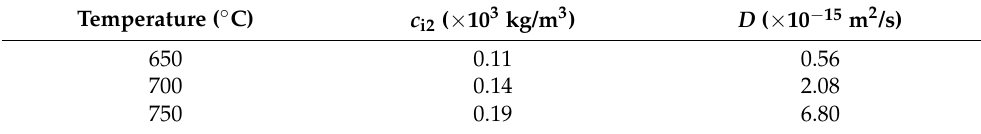
Table 7. The concentration of Ti ( c i2 ) and the diffusion coefficient at different temperature. Temperature ( ◦